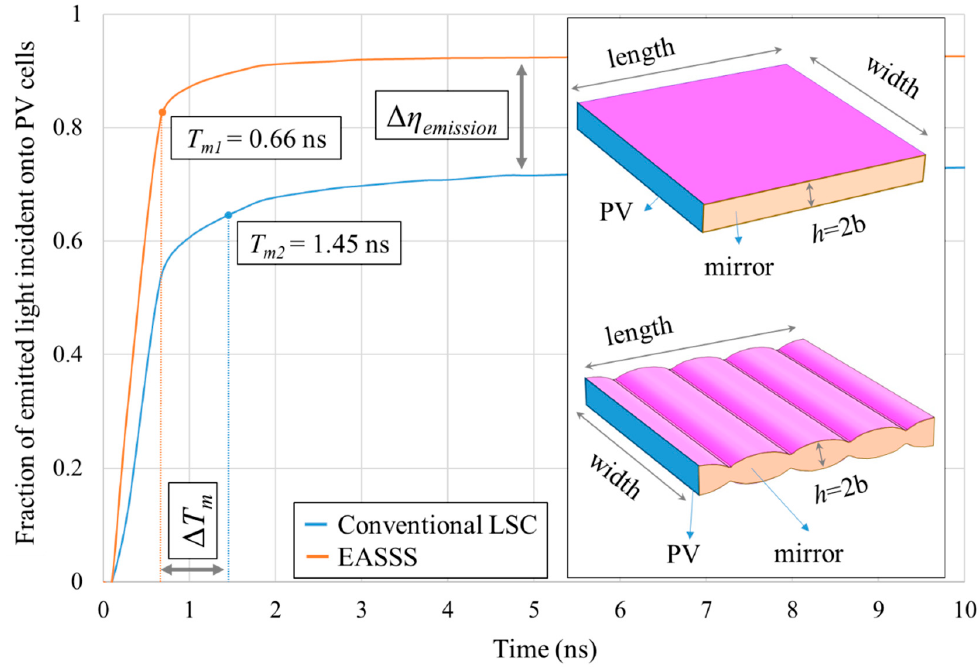
Figure 11. Fraction of photons emitted within the EASSS and conventional LSC panels incident onto PV cells located at the panel sidewalls as a function of time.